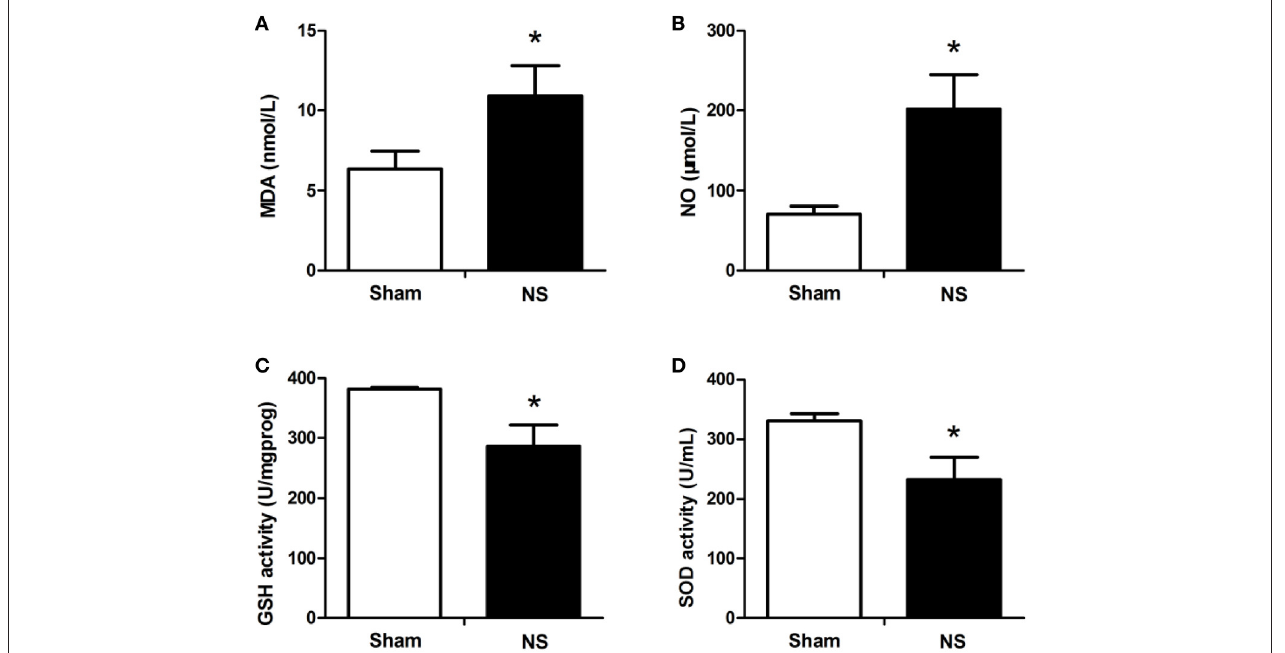
FIGURE 1 | ELISA results of MDA, NO, GSH-Px. and SOD expression in the spinal cords between the NS and Sham groups. Compared with the Sham group, I/R injury significantly increased the levels of MDA (A) and NO (B) and decreased the levels of GSH-Px (C) and SOD (D) . The blood samples were harvested from the spinal cord I/R and sham rabbits at 48h after operation. The differences between two groups were analyzed using by the Student’s t -test. Bars represent mean ± SD ( n = 6–8). * P < 0.05 vs. the Sham group.